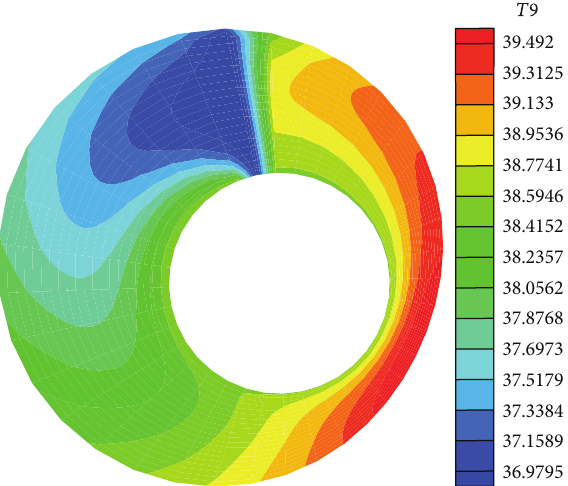
Figure 4: Isothermal lines of the journal bearing at its central plan for 𝑁 = 1000 rev./min and 𝑛 = 0.9 .